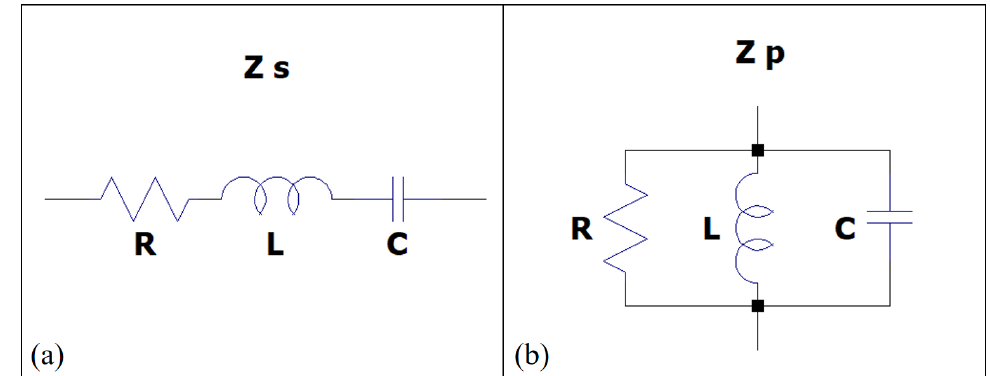
Figure 4. Serial ( a ) and parallel ( b ) impedances for RLC models.